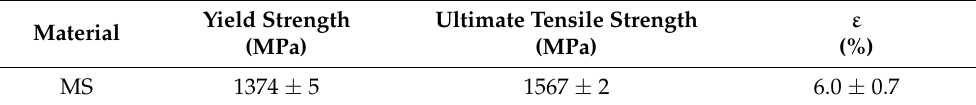
Table 2. Mechanical properties of the martensitic steel (MS) measured by the uniaxial tensile test. Yield Strength Material